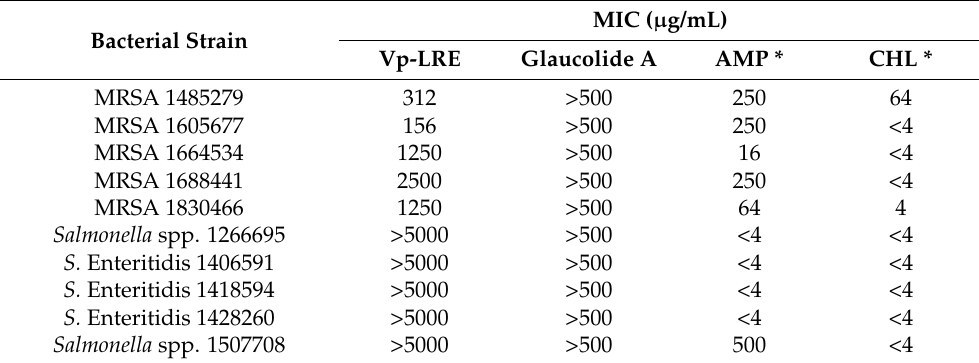
Table 3. Minimal inhibitory concentration (MIC) values of V. polyanthes leaf rinse extract (Vp-LRE) and glaucolide A against clinical strains.